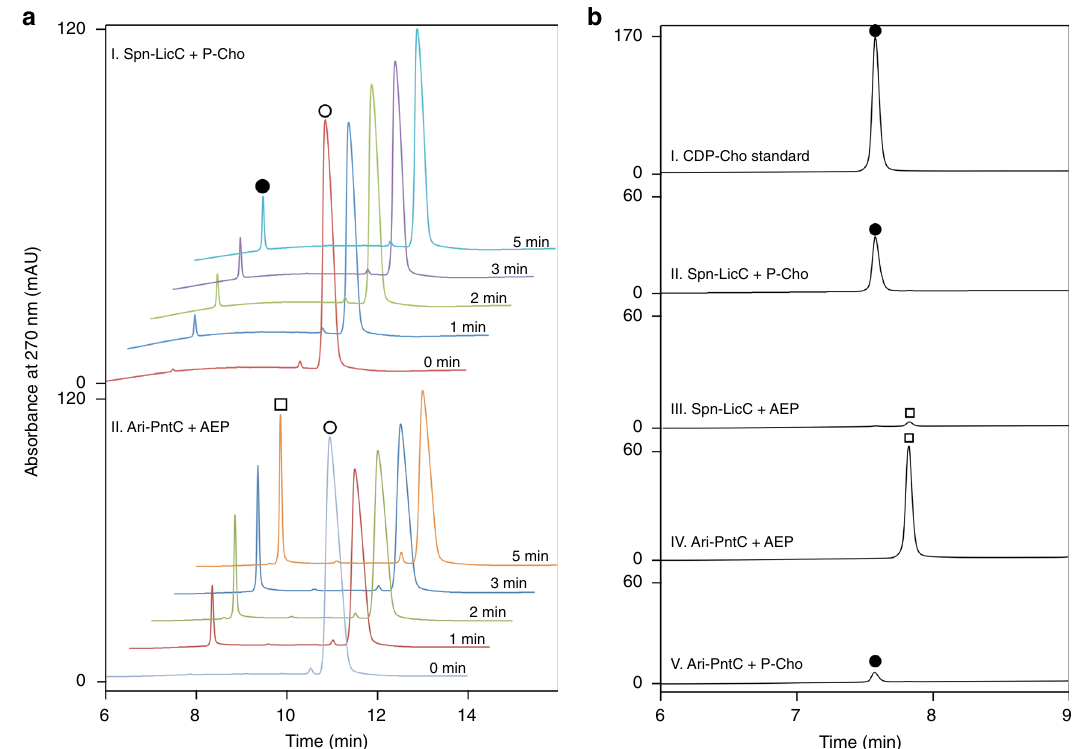
Fig. 4 HPLC chromatograms of reactions catalyzed by Spn-LicC and Ari-PntC (Ari1348). a Time-resolved reaction of CTP (open circle) with: I, P-Cho and Spn-LicC to make CDP-Cho ( fi lled circle), and II, AEP and Ari-PntC to generate CMP-AEP (open square). b Spn-LicC more readily produces CDP-Cho (panel II) than CMP-AEP (panel III); in contrast, Ari-PntC preferentially generates CMP-AEP (panel IV) compared to CDP-Cho (panel V) after 30 min of reaction time. All reactions contained 50 nM enzyme, 1 mM of either AEP or P-Cho, 4 mM CTP, and 7 mM MgCl 2 in 50 mM Tris – Cl, pH 8.0 Table 1 Steady-state kinetic constants of cytidylyltransferases a